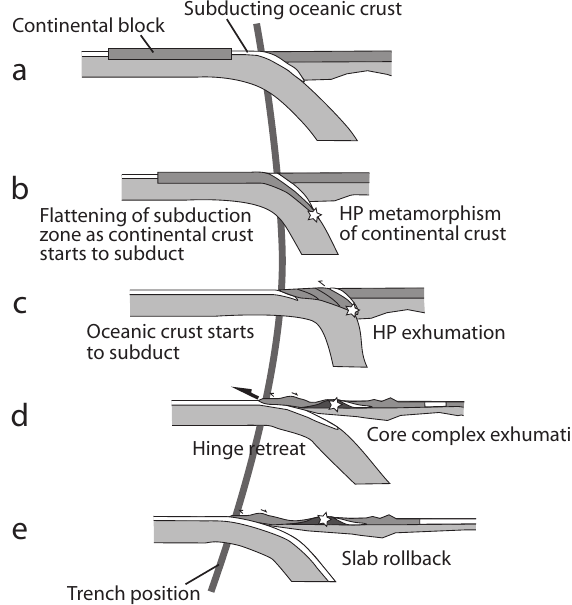
Fig. 5. Figure modified from Brun and Faccenna (2008) showing the interpreted development of slab rollback tectonics and the ex- humation of high-pressure rocks in domal culminations within that